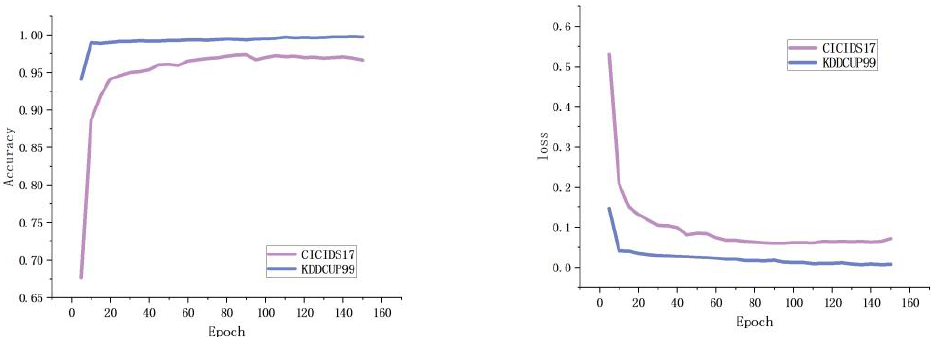
Figure 4. Accuracy and loss variation when models are trained using CICIDS17, KDDCUP99 da- taset.